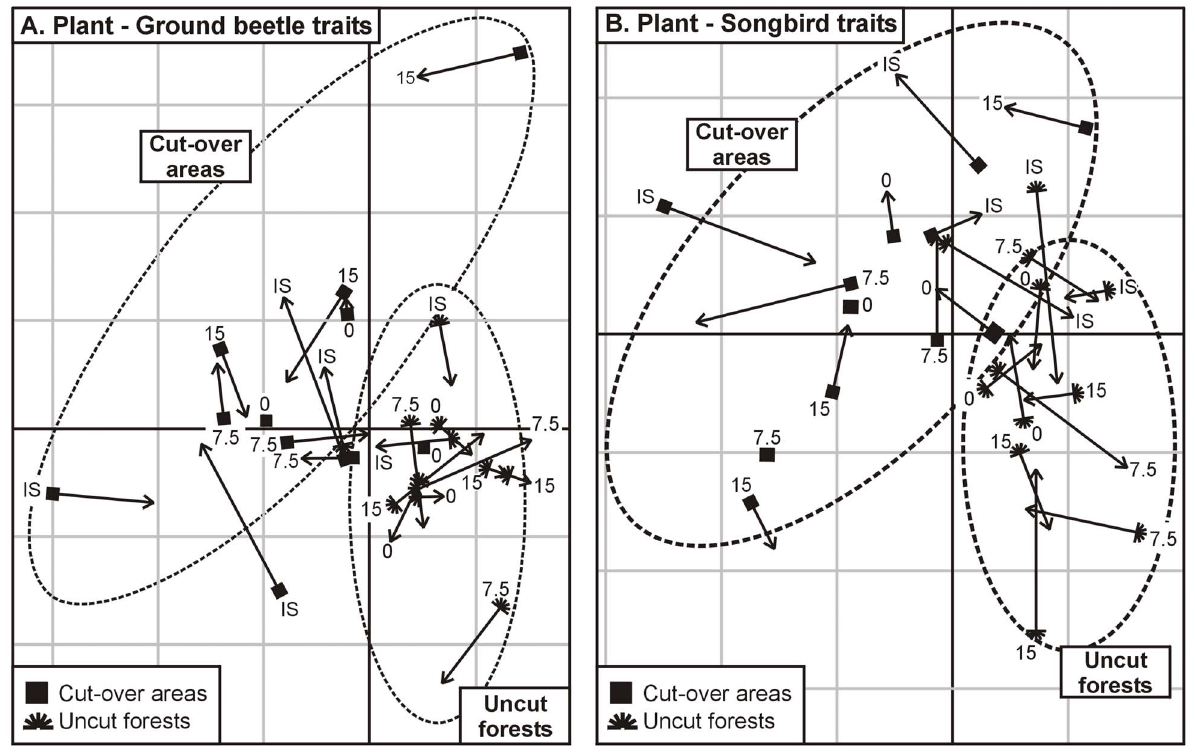
Figure 4. Relationship between plants and fauna traits after deer density reduction and logging. Co-inertia analyses comparing the distribution of plant and ground beetle (A) and plant and songbird (B) community trait compositions in the 24 experimental units (three blocks; four densities: 0, 7.5, 15 deer ? km 2 2 and in situ (IS) density . 27 deer ? km 2 2 ; two vegetation cover types: uncut forests and cut-over areas). Arrows link plant and animal trait communities. The arrow tail represents the plant traits and the head the animal traits, while arrow length indicates the strength